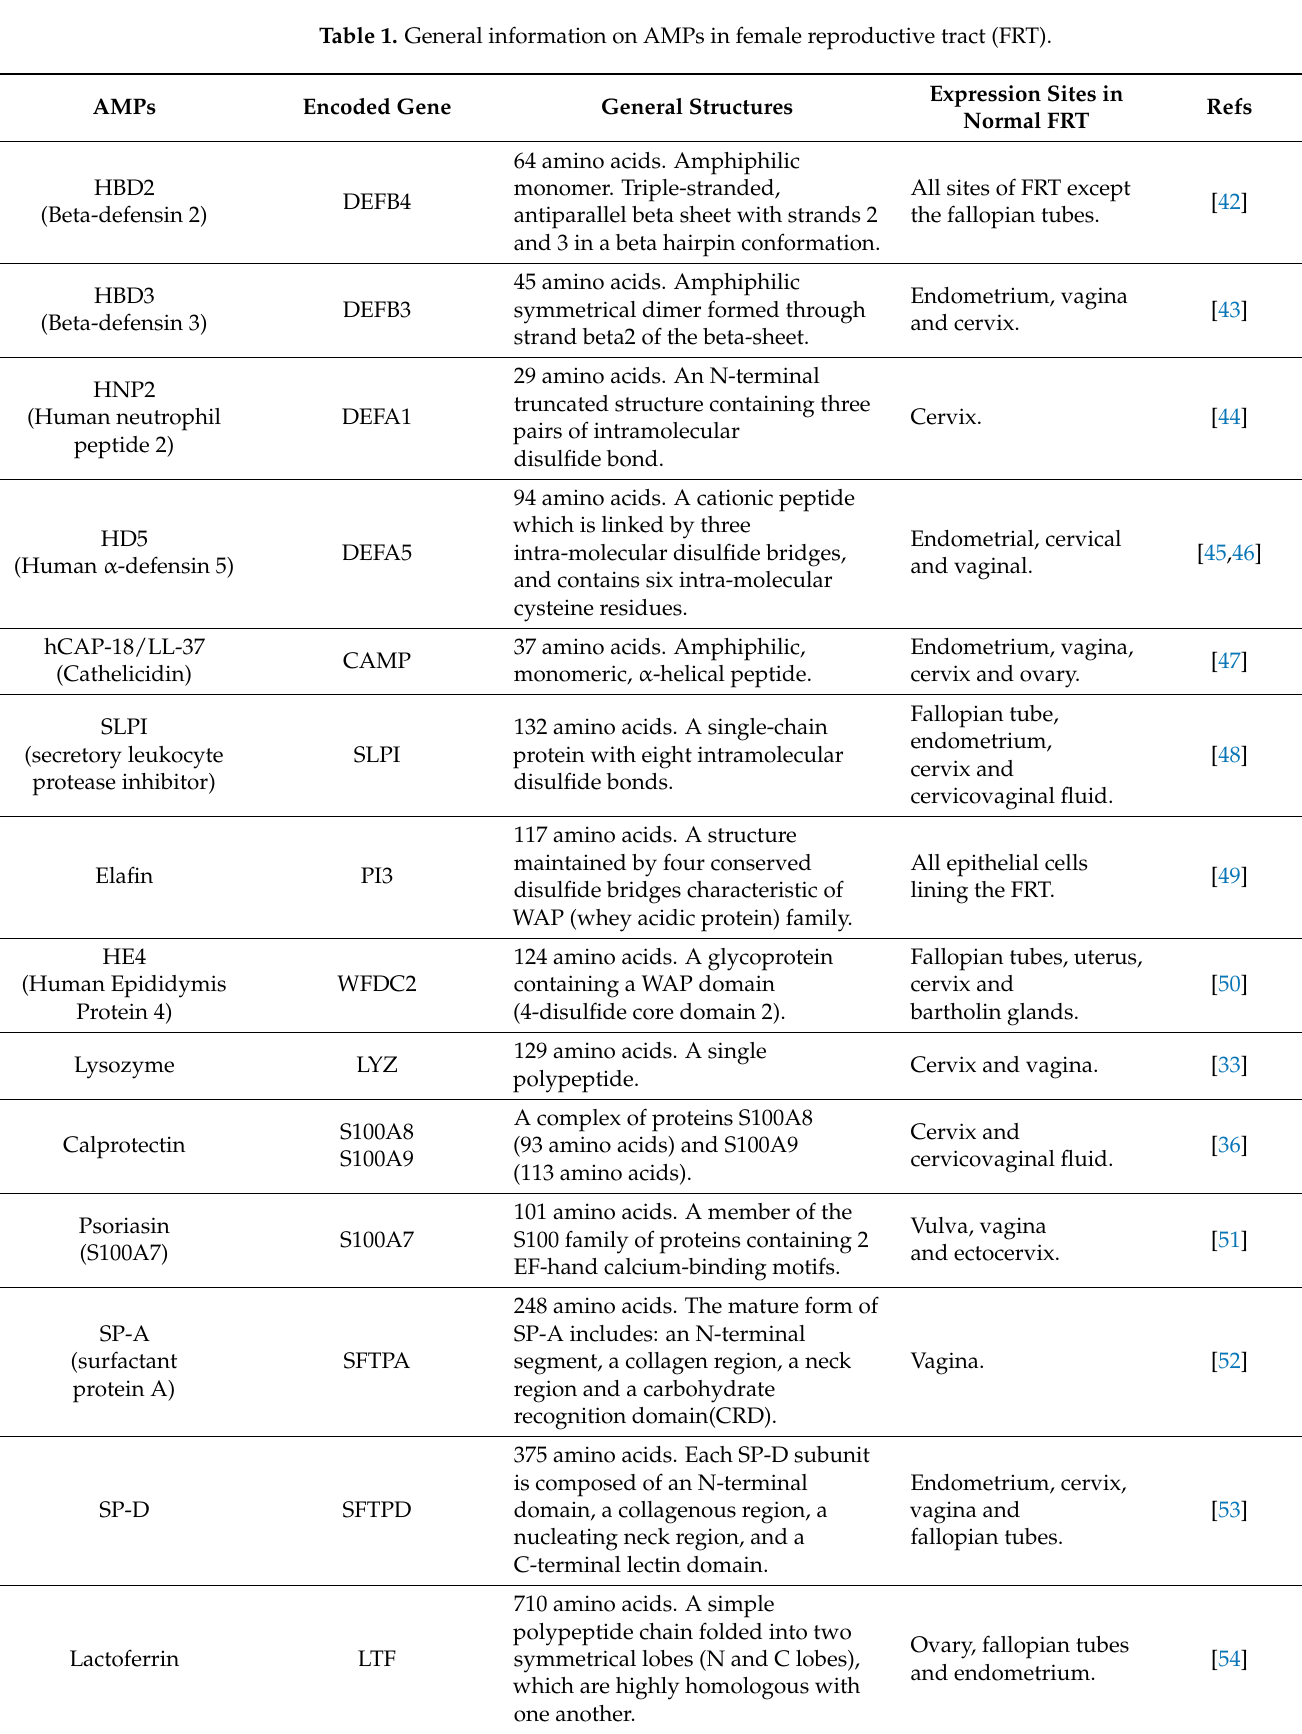
Table 1. General information on AMPs in female reproductive tract